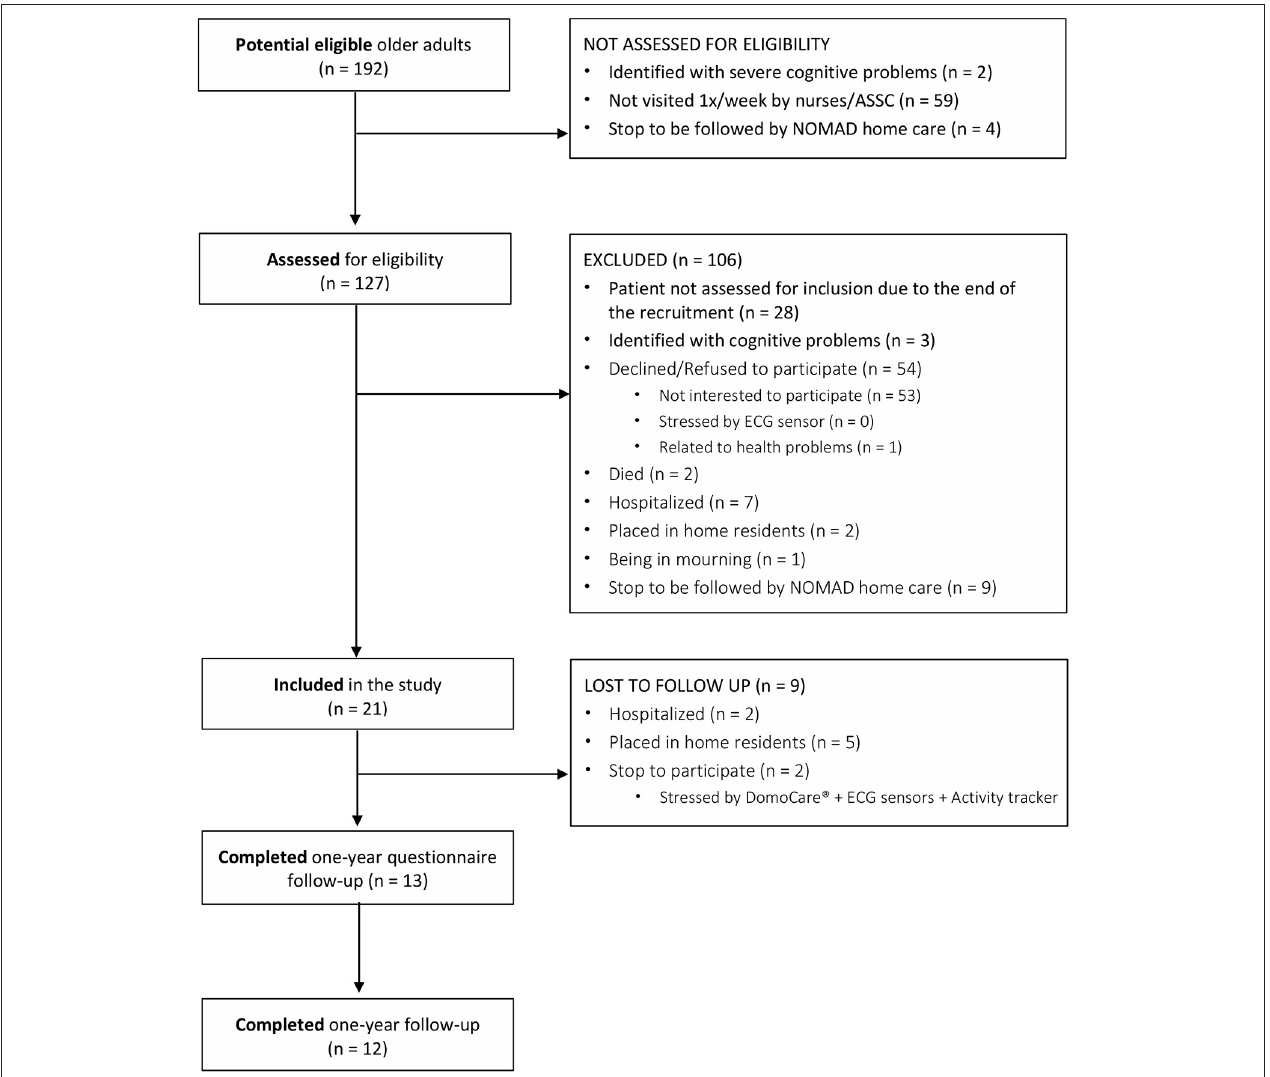
FIGURE 1 | Flow diagram of home-dwelling older